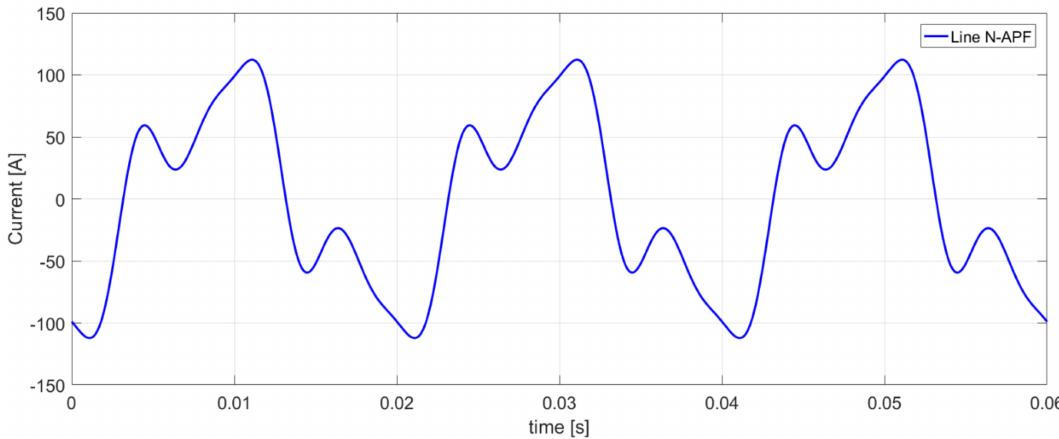
Figure 11. The waveform of the reference current in cross-section